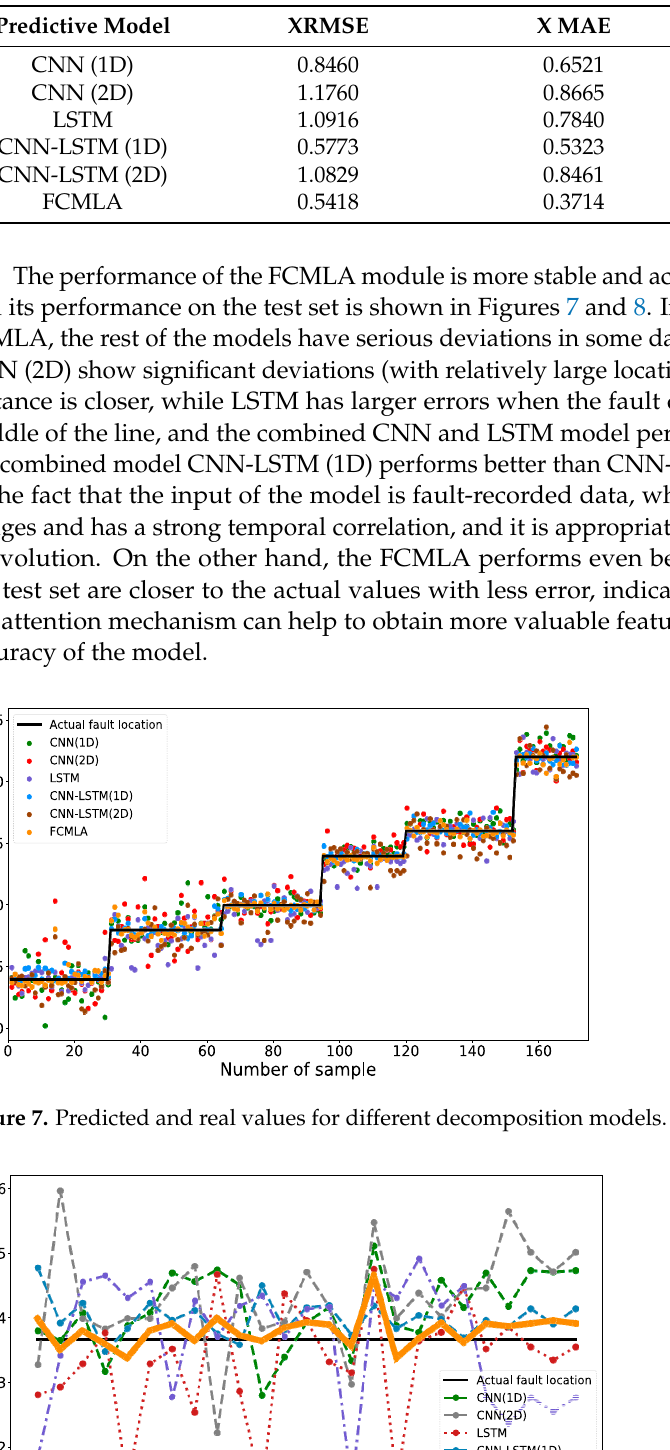
Table 1. Fault location performance of different models.